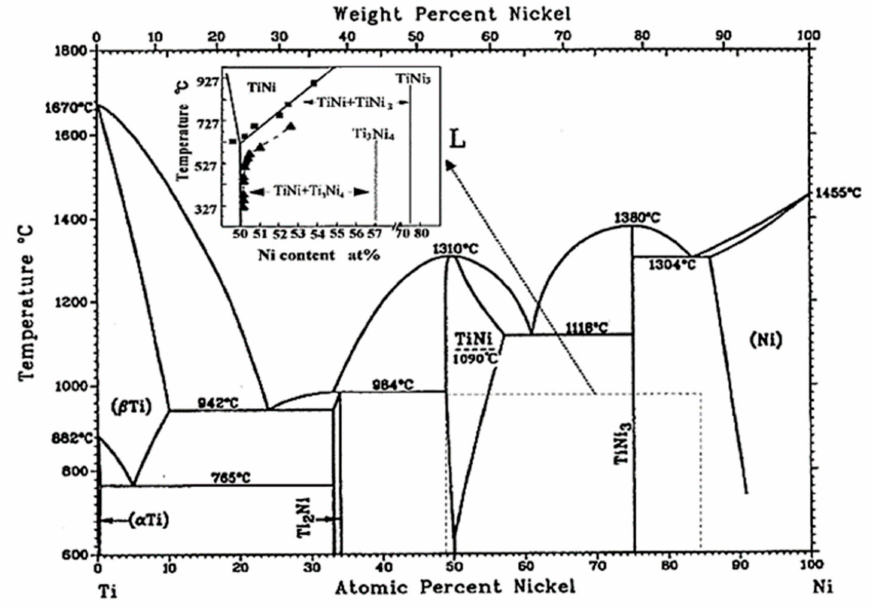
Figure 1. Binary NiTi phase diagram